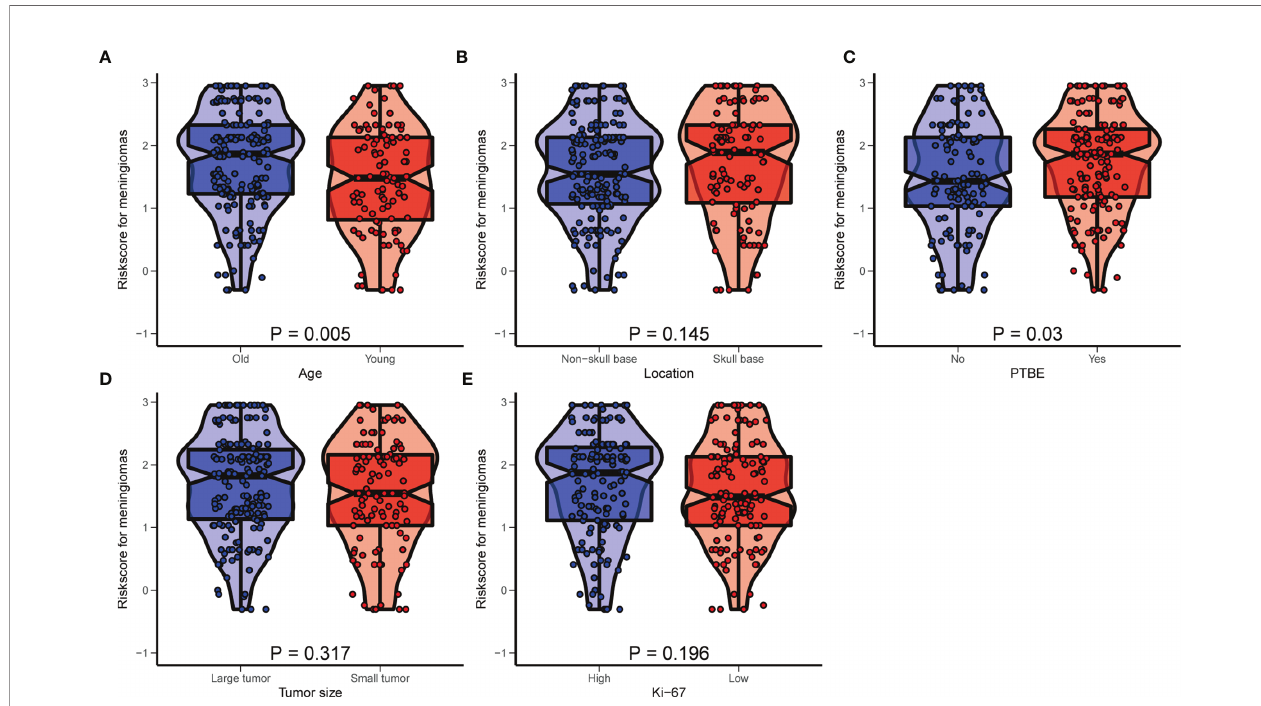
FIGURE 4 | The distribution of hematological risk score in different subgroup. (A) Old patients ≥ 51 years old, young patients <51 years old; (B) Patients were divided into the non-skull base group and skull group according to the tumor location. (C) PTBE, peritumoral edema; (D) large tumor: maximum size ≥ 4.2 cm, small tumor: maximum size <4.2 cm; (E) high Ki-67 index: ≥ 10%, low Ki-67 index: